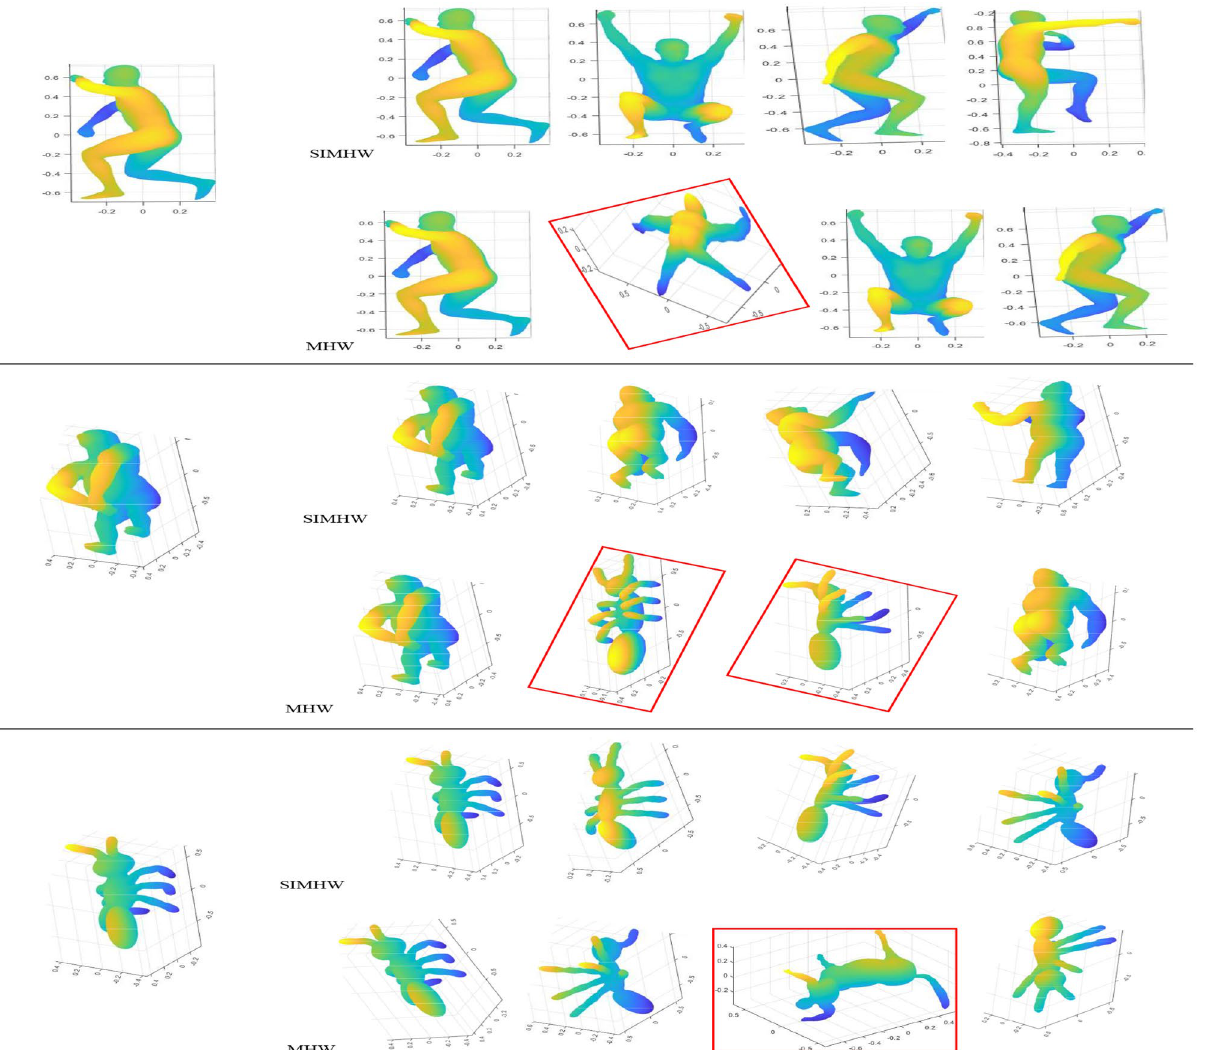
Figure 10. Shape retrieval results (SHREC2015). Left: queries; right: first matches using SIMHW and